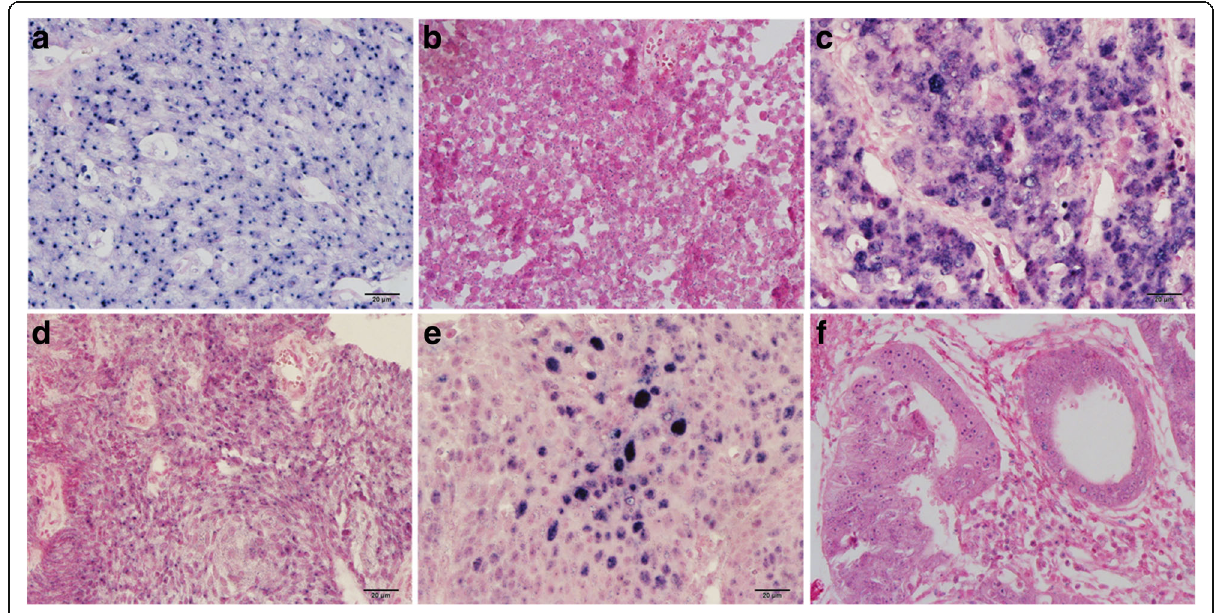
Fig. 3 HPV DNA detection using in situ hybridization (×400). a Small cell carcinoma illustrated punctate staining pattern with one navy-blue puncta signal in the nuclei. b Multiple small puncta inside the nuclei of small cell carcinoma represents low viral copy number of HPV DNA. c Diffuse small particles were observed in the nuclei of small cell carcinoma. d Squamous cell carcinoma displayed punctuate signal patterns. e Squamous cell carcinoma illustrated episomal staining pattern. f Tumor cells of adenocarcinoma positive with one navy-blue